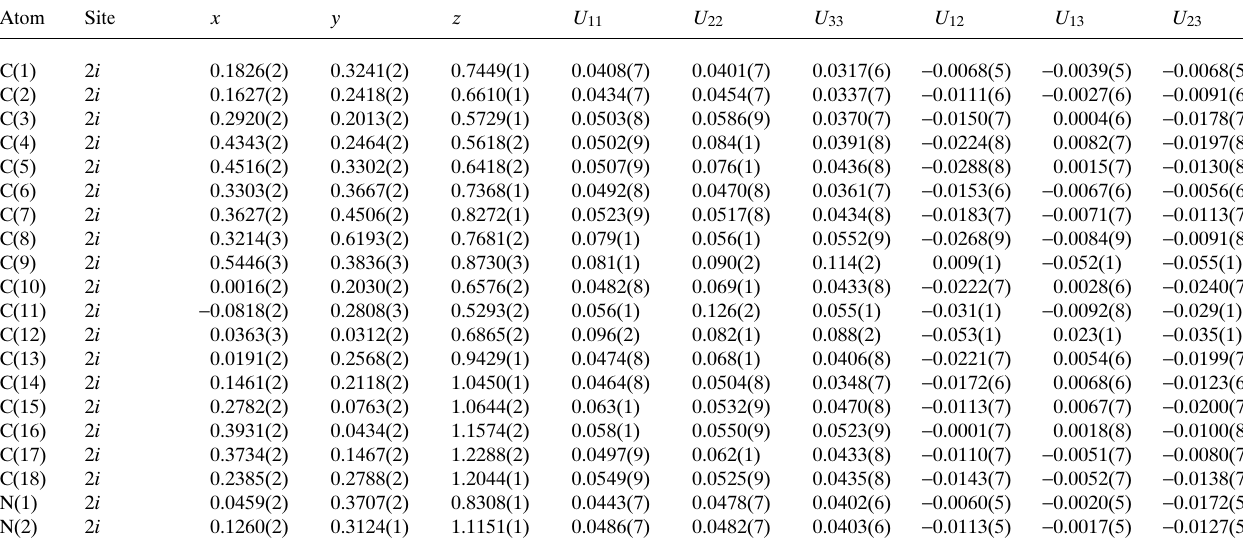
Table 3. Atomic coordinates and displacement parameters (in Å 2 )